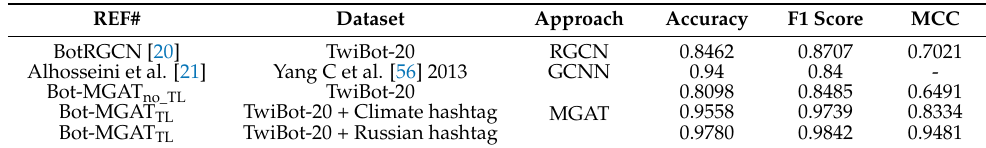
Table 8. Bot-MGAT performance compared to